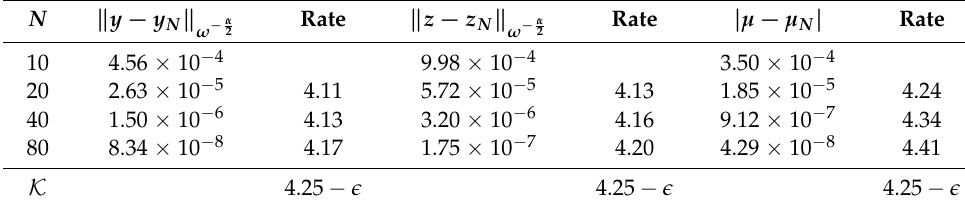
Table 2. Errors and convergence rates of y , z in weighted L 2 norm and µ with α = 1.50. N